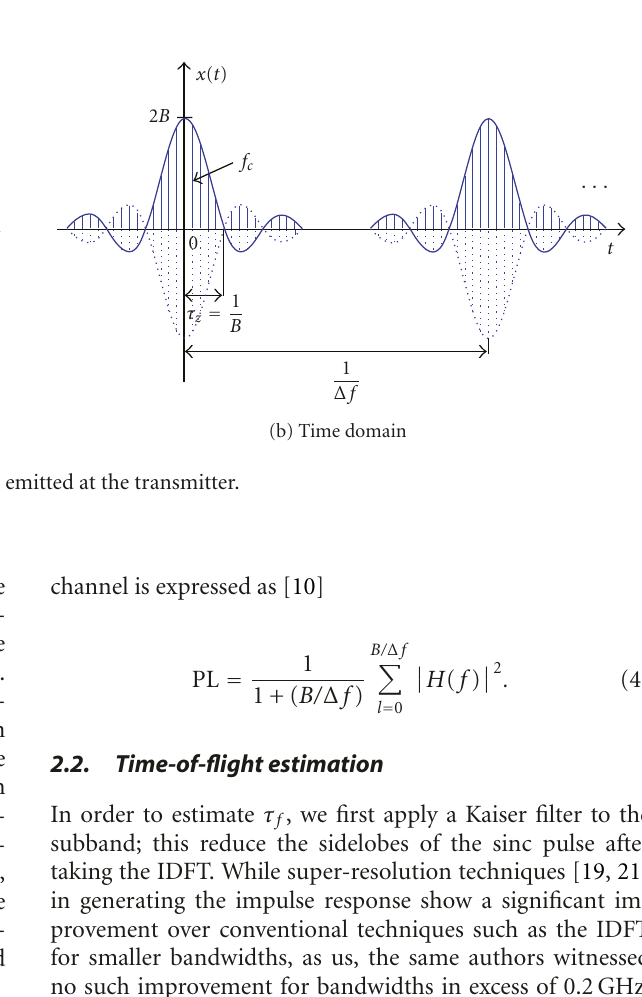
Figure 1: The impulse response of the channel.